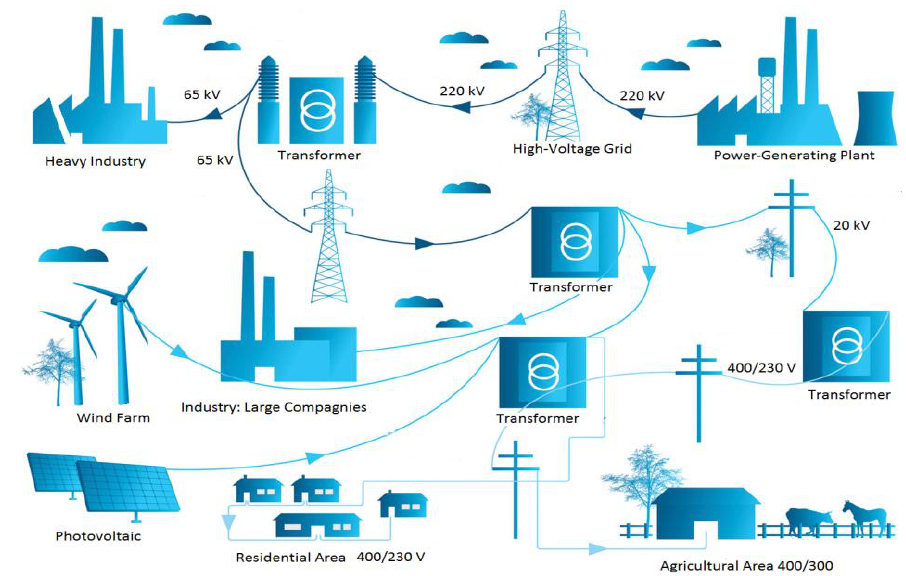
Figure 1 . Schematic diagram of an electric power system. Figure 1. Schematic diagram of an electric power